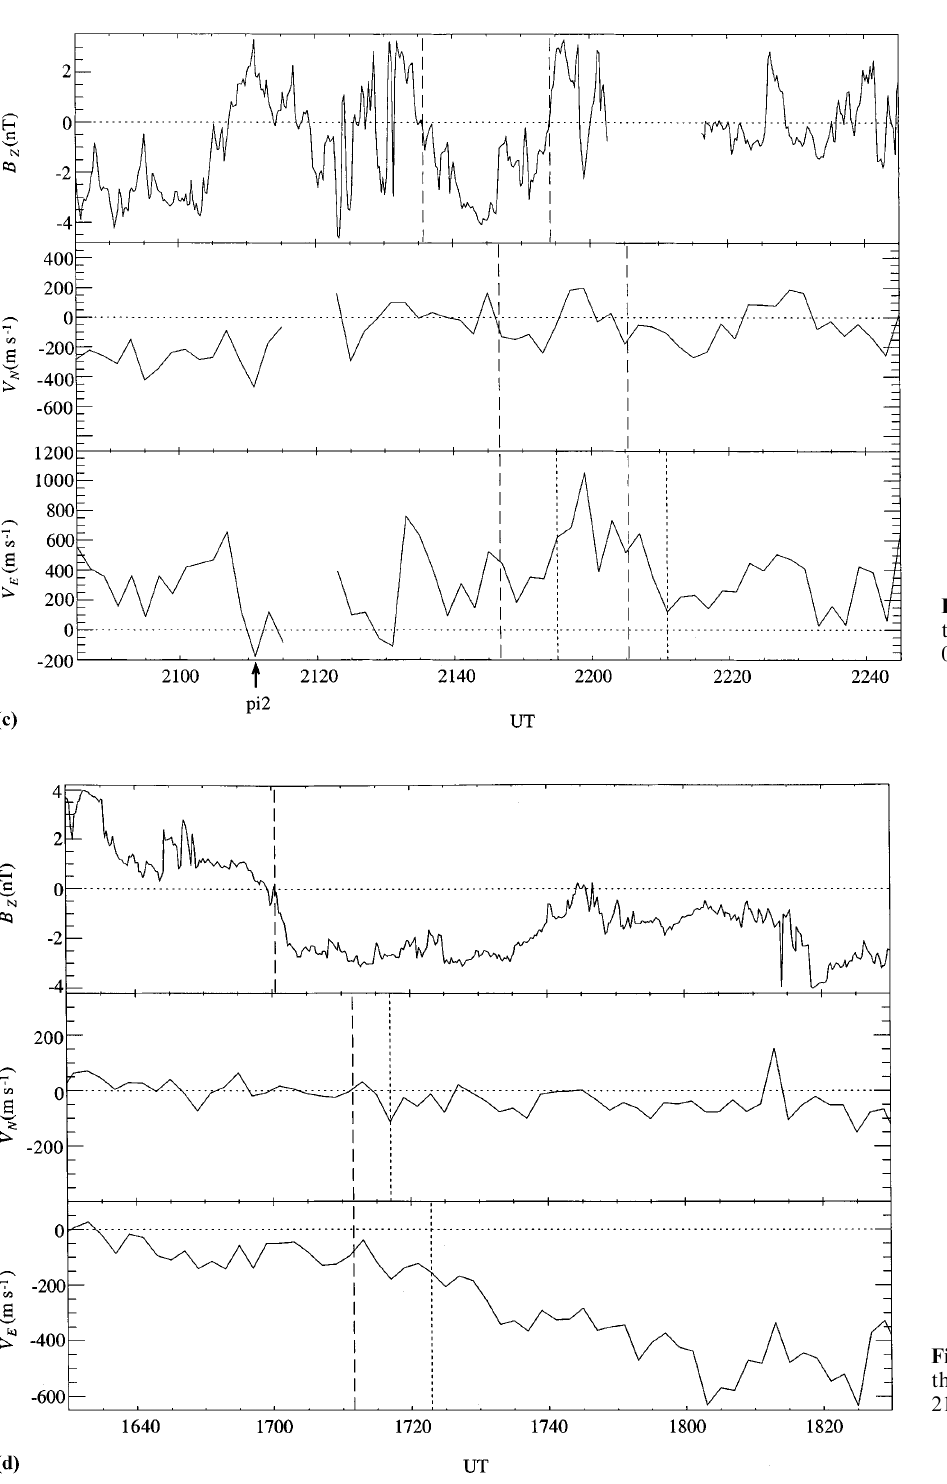
Fig. 6. d As for Fig. 2, except for the interval 1630–1830 UT (1900– 2100 MLT) on 18 June, 1996